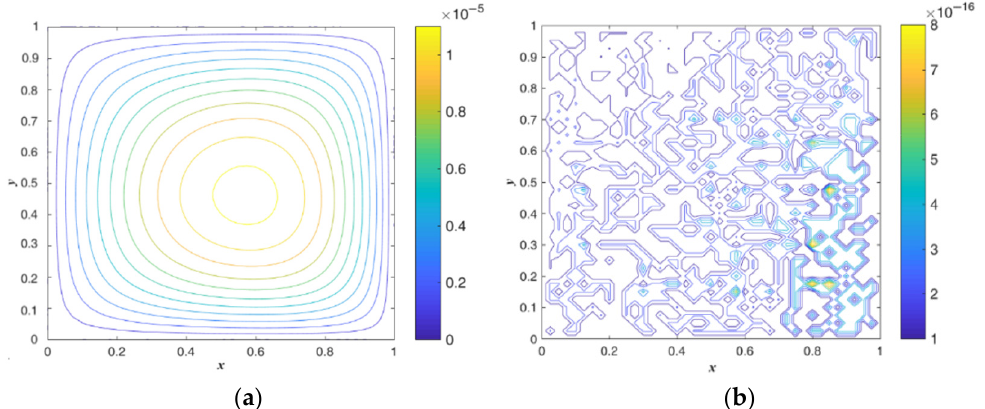
Figure 6. For Example 1: the contour of the absolute errors of 𝐸 (cid:3051)(cid:3052)(cid:3053) = 10 (cid:2872) and 𝐸 (cid:3051)(cid:3052)(cid:3053) = 10 (cid:2869)(cid:2872) . ( a ) 𝐸 (cid:3051)(cid:3052)(cid:3053) = 10 (cid:2872) ; ( b ) 𝐸 (cid:3051)(cid:3052)(cid:3053) = 10 (cid:2869)(cid:2872) .